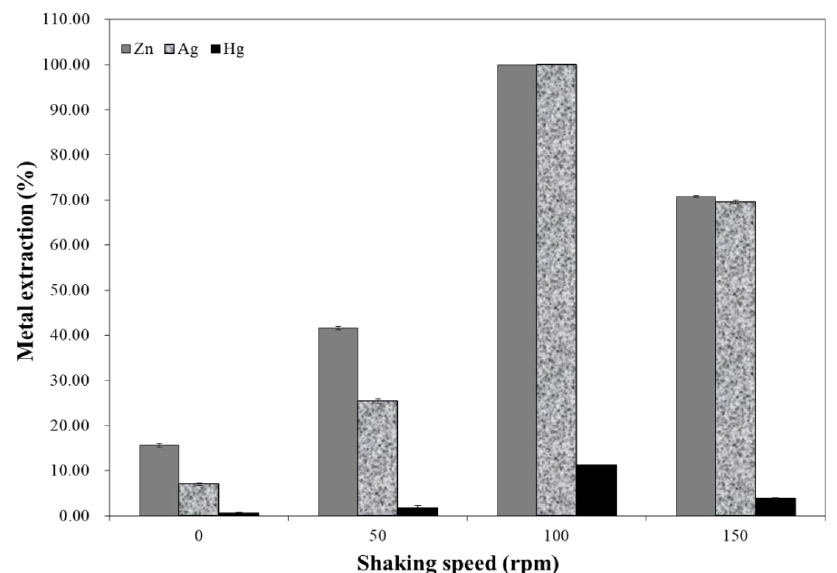
Figure 3. Effect of shaking speed on metal leaching using 100 mL A. niger spent medium after six hours of incubation at 60 °C.